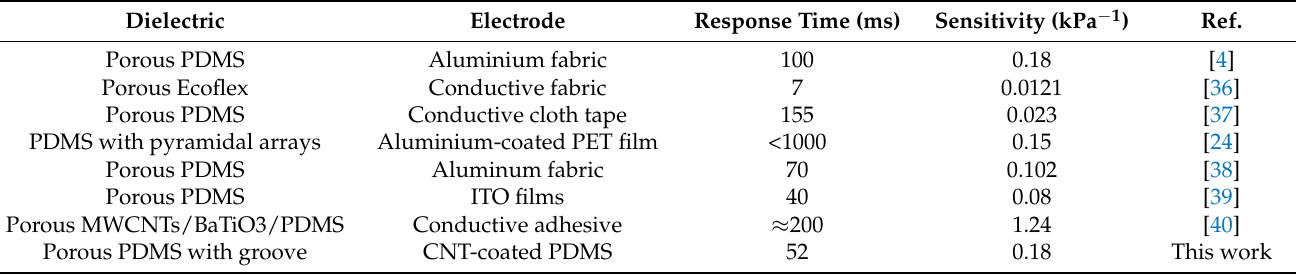
Table 1. Comparison of the materials and key parameters of several sensors.